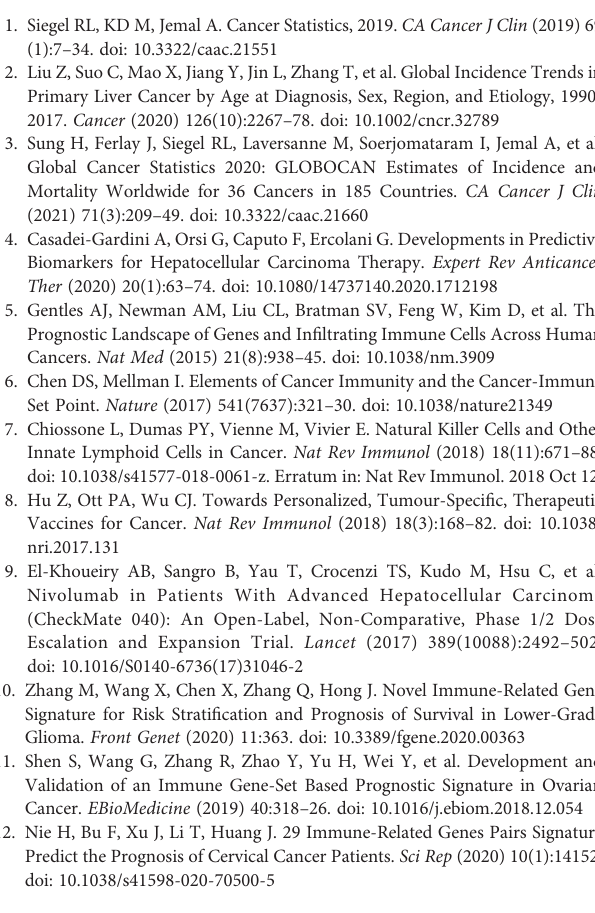
Supplementary Figure 1 | Results of internal veri fi cation. (A) The KM- survival curve of TCGA-Train set and TCGA-Test set. (B) The ROC curve of TCGA-Train set and TCGA-Test set. Supplementary Data Sheet 1 | — The data of 11 genes obtained by lasso regression analysis. Supplementary Data Sheet 2 | — Riskvalue fi leforpatientsintheTCGA-LIHCcohort. Supplementary Data Sheet 3 | — Risk value fi le for patients in the ICGC liver cancer cohort. Supplementary Data Sheet 4 | — The data of 108 differentially expressed genes related to the signal transduction pathway of p53 mediators. Supplementary Data Sheet 5 | — Clinical information of patients in TCGA cohort. Supplementary Data Sheet 6 | — Clinical information of patients in ICGC cohort. Supplementary Data Sheet 7 | — Key codes applied in